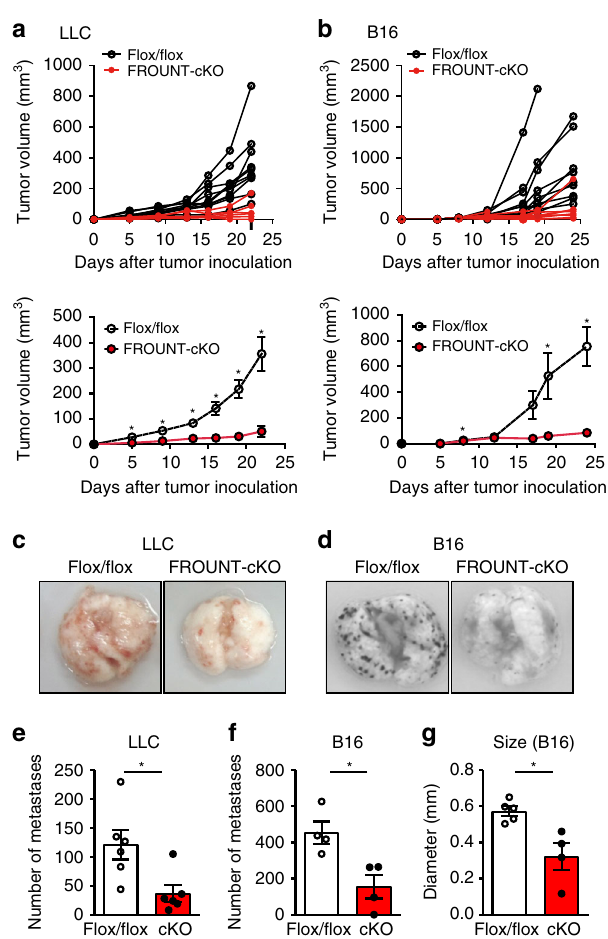
Fig. 2 FROUNT de fi ciency in the host impaired tumor progression and metastasis. a , b Individual (upper graph) and combined (lower graph) tumor-growth kinetics in Frount - fl oxed (Flox/ fl ox) or conditional knockout (FROUNT-cKO) mice inoculated subcutaneously with Lewis lung carcinoma (LLC) (Flox/ fl ox: n = 12, cKO: n = 11) ( a ) or B16 melanoma (B16) cells (Flox/ fl ox: n = 10, cKO: n = 10) ( b ). c – g Lung metastasis was examined by injecting LLC ( c and e ) or B16 ( d , f , and g ) tumor cells intravenously into Flox/ fl ox or FROUNT-cKO mice. Representative images of tumor-bearing lungs ( c , d ); number ( n = 6 for LLC and = 4 for B16) ( e, f ) and size (Flox/ fl ox: n = 5, cKO: n = 4) ( g ) of visible metastatic nodules. * P < 0.05 by two-tailed, unpaired Student ’ s t -test. Error bars indicate